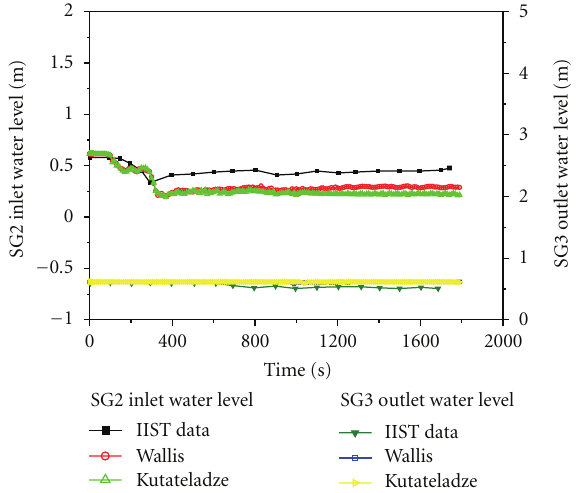
Figure 7: The comparison of SG2 inlet and SG3 outlet water level among Wallis form, Kutateladze form, and IIST data.